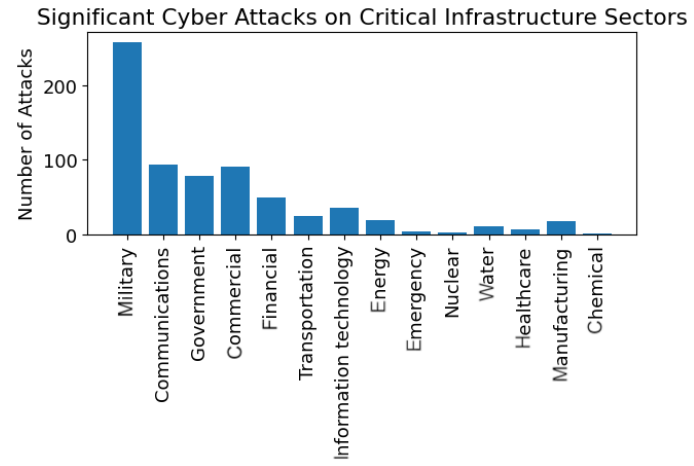
Figure 4. Significant cyber attacks by the CI sector since 2006, analyzed from the CSIS incidents